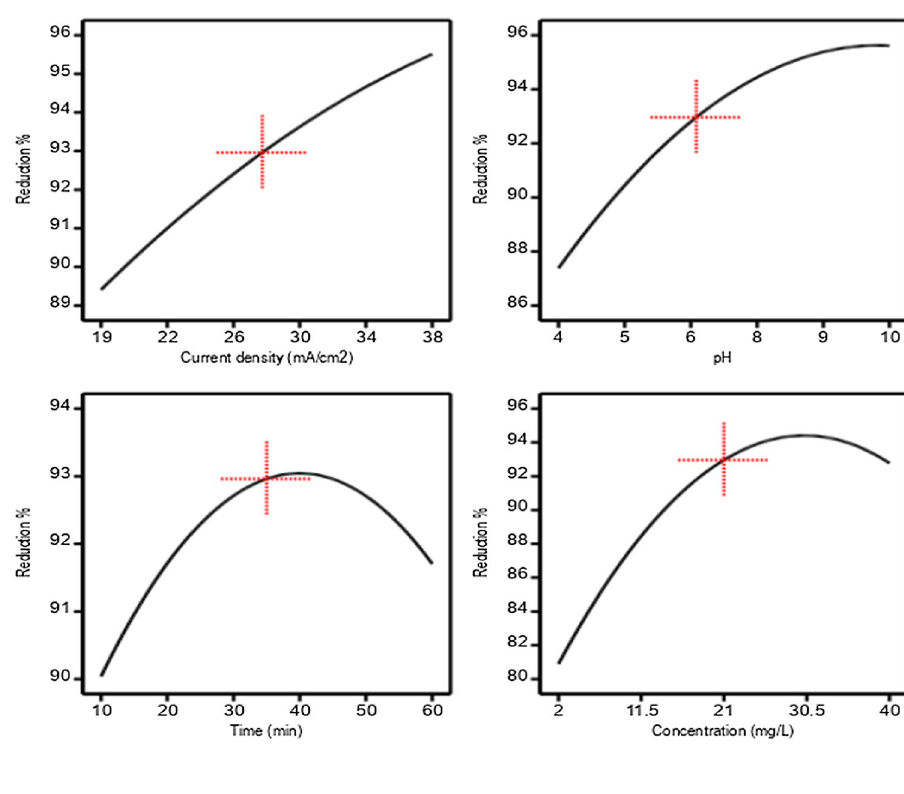
Fig. 6 Main effect plots of parameters for fluoride removal efficiency on Fe-EC